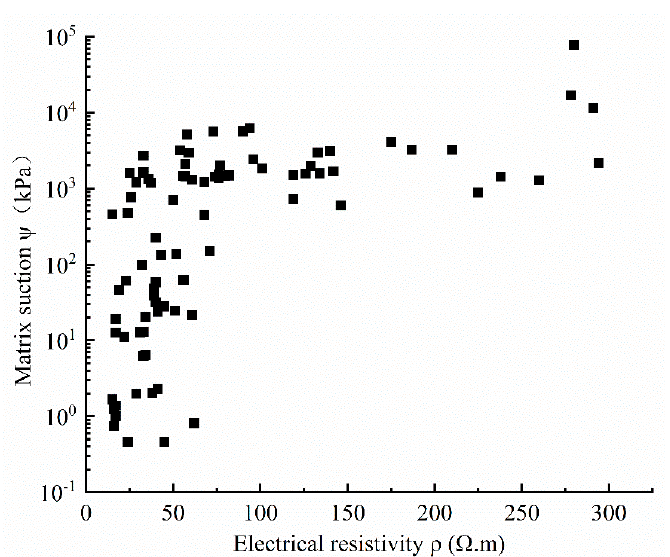
Figure 6. 𝜓 − 𝜌 relationship diagram. Figure 6. ψ - ρ relationship